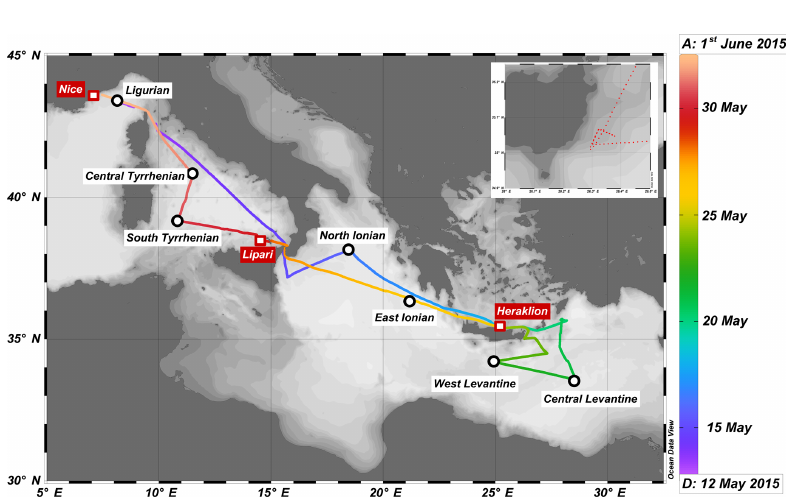
Figure 1. Cruise track plotted on a time line (color bar). Port calls are marked by red squares, and stations are marked by black circles. Detail of the L-shape track in the eastern coast of